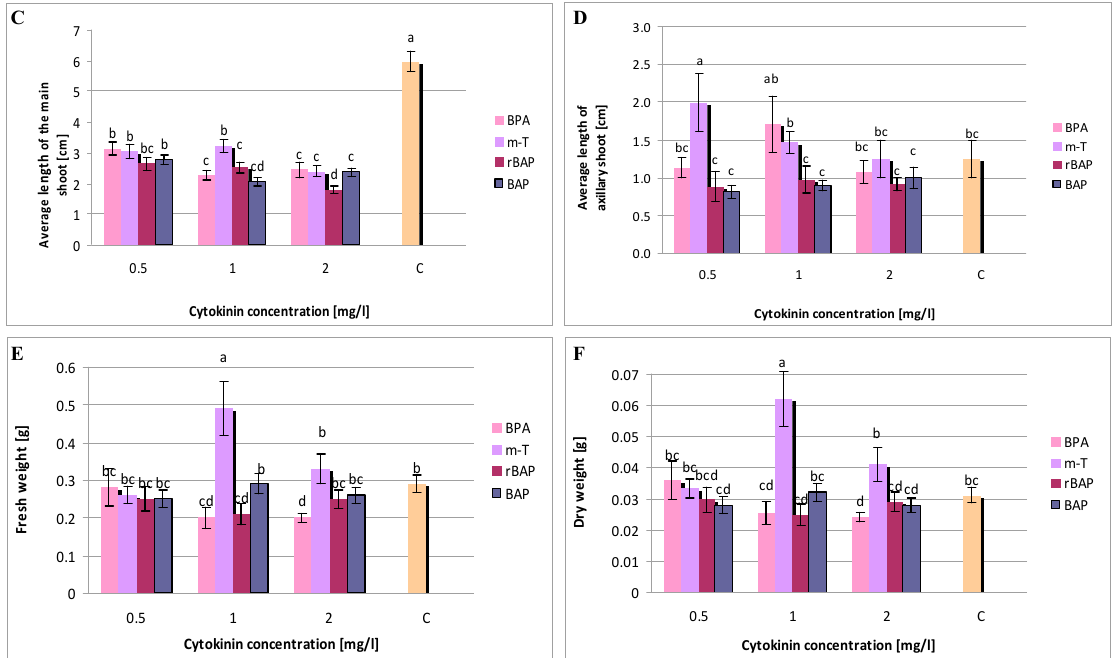
Figure 2. Effect of cytokinin type and concentration on: ( A ) proliferative response (%), ( B ) proliferation rate, ( C ) length of the main shoot, ( D ) length of the axillary shoots, ( E ) fresh weight, and ( F ) dry weight of culture of S. viridis. C- control, shoots cultivated on MS medium only with auxin (0.1 mg/L IAA). The values represent the mean ± standard error of three independent experiments. Means marked with the same letter were not significantly different according to the one-way ANOVA test, followed by the post hoc Tukey’s test for multiple comparison ( p ≤ 0.05).